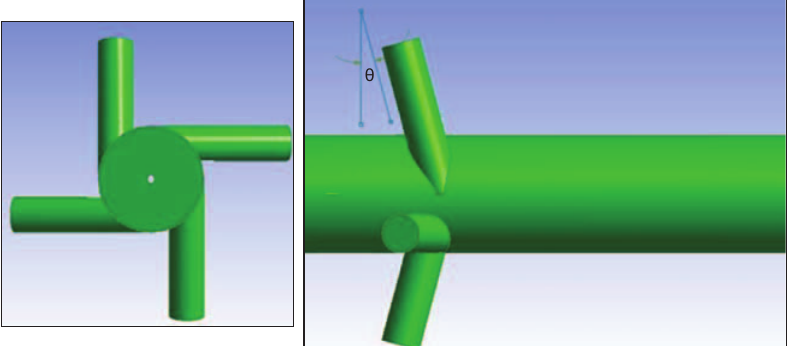
Figure 3 The profi le of injectors and vertical